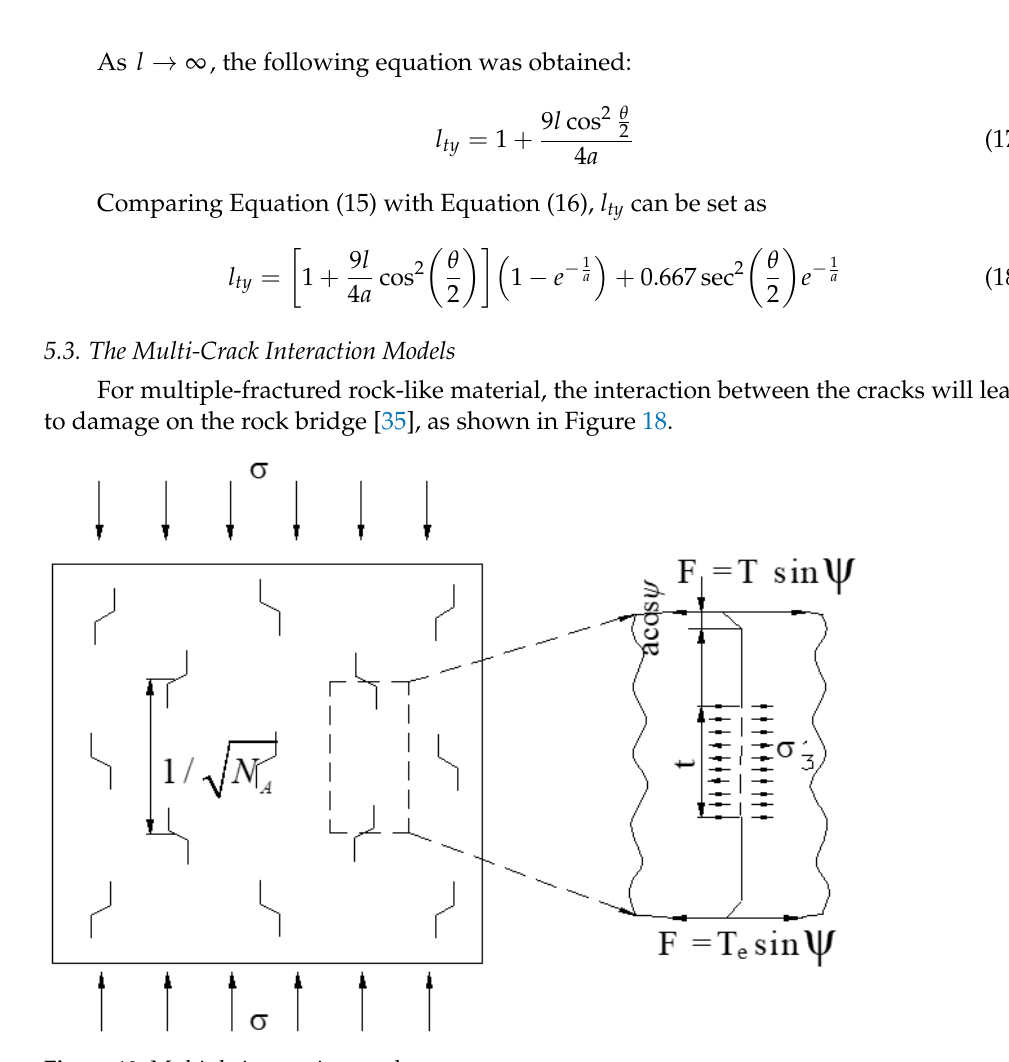
Figure 18. Multiple interacting cracks.